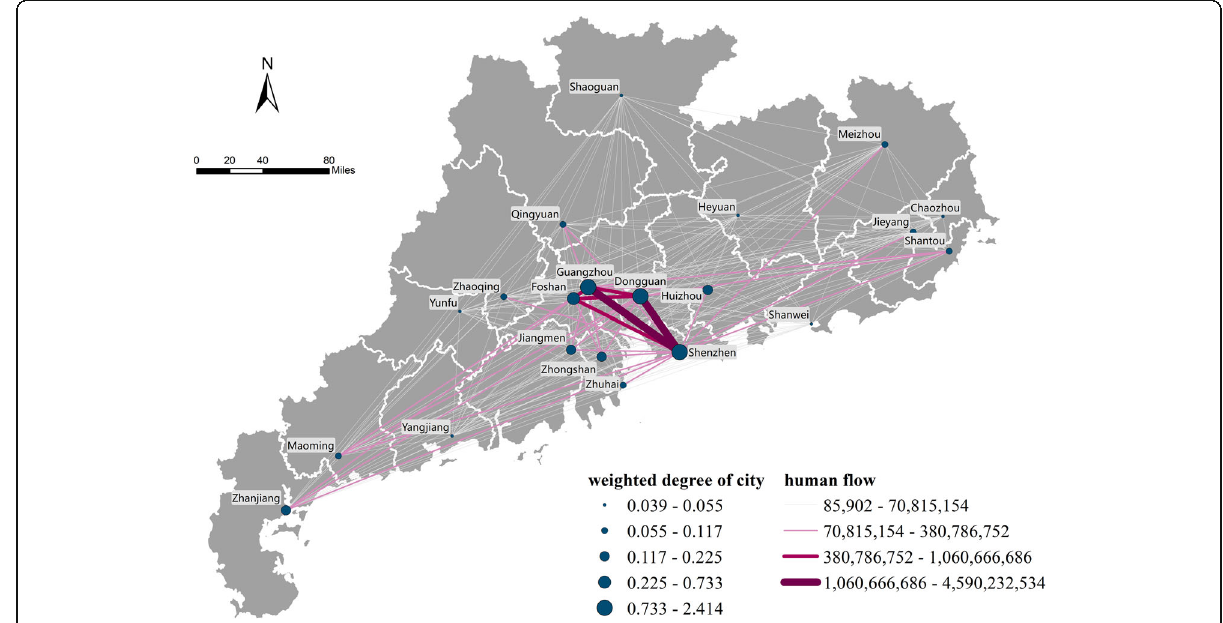
Fig. 3 Human flow network in Guangdong